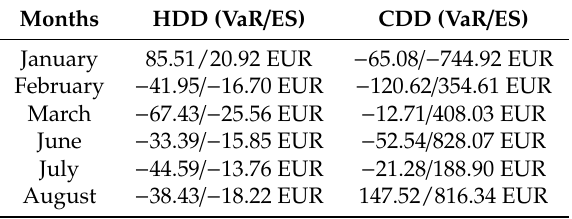
Table 6. HDD and CDD Profit / Losses for 2017—Prices in Table 5 have been compared with actual 2017 pay-o ff